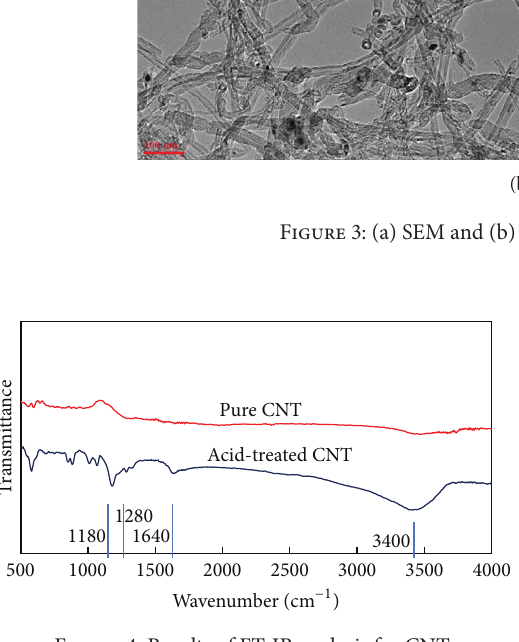
Figure 4: Results of FT-IR analysis for